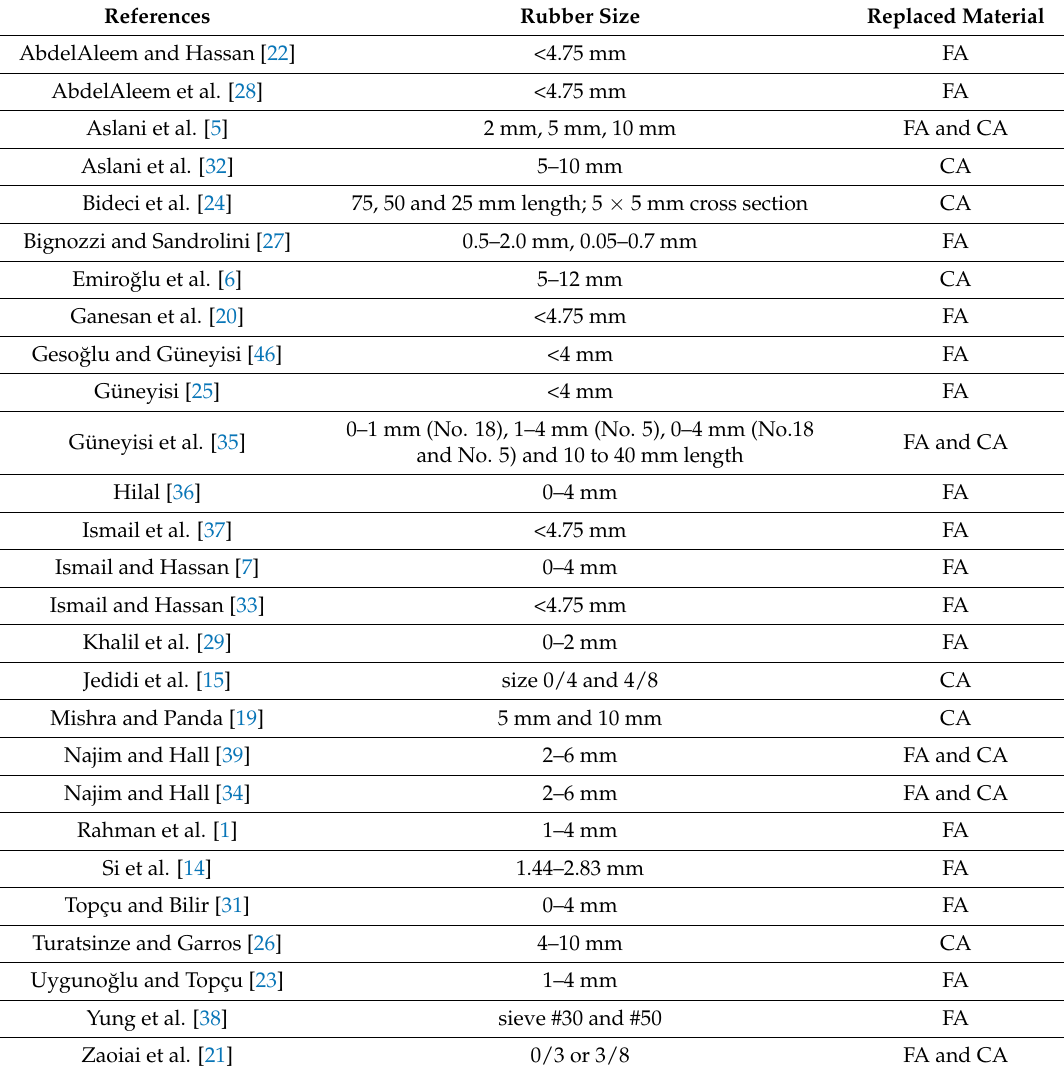
Table 8. Rubber size and replaced material (fine and/or coarse aggregate) of different